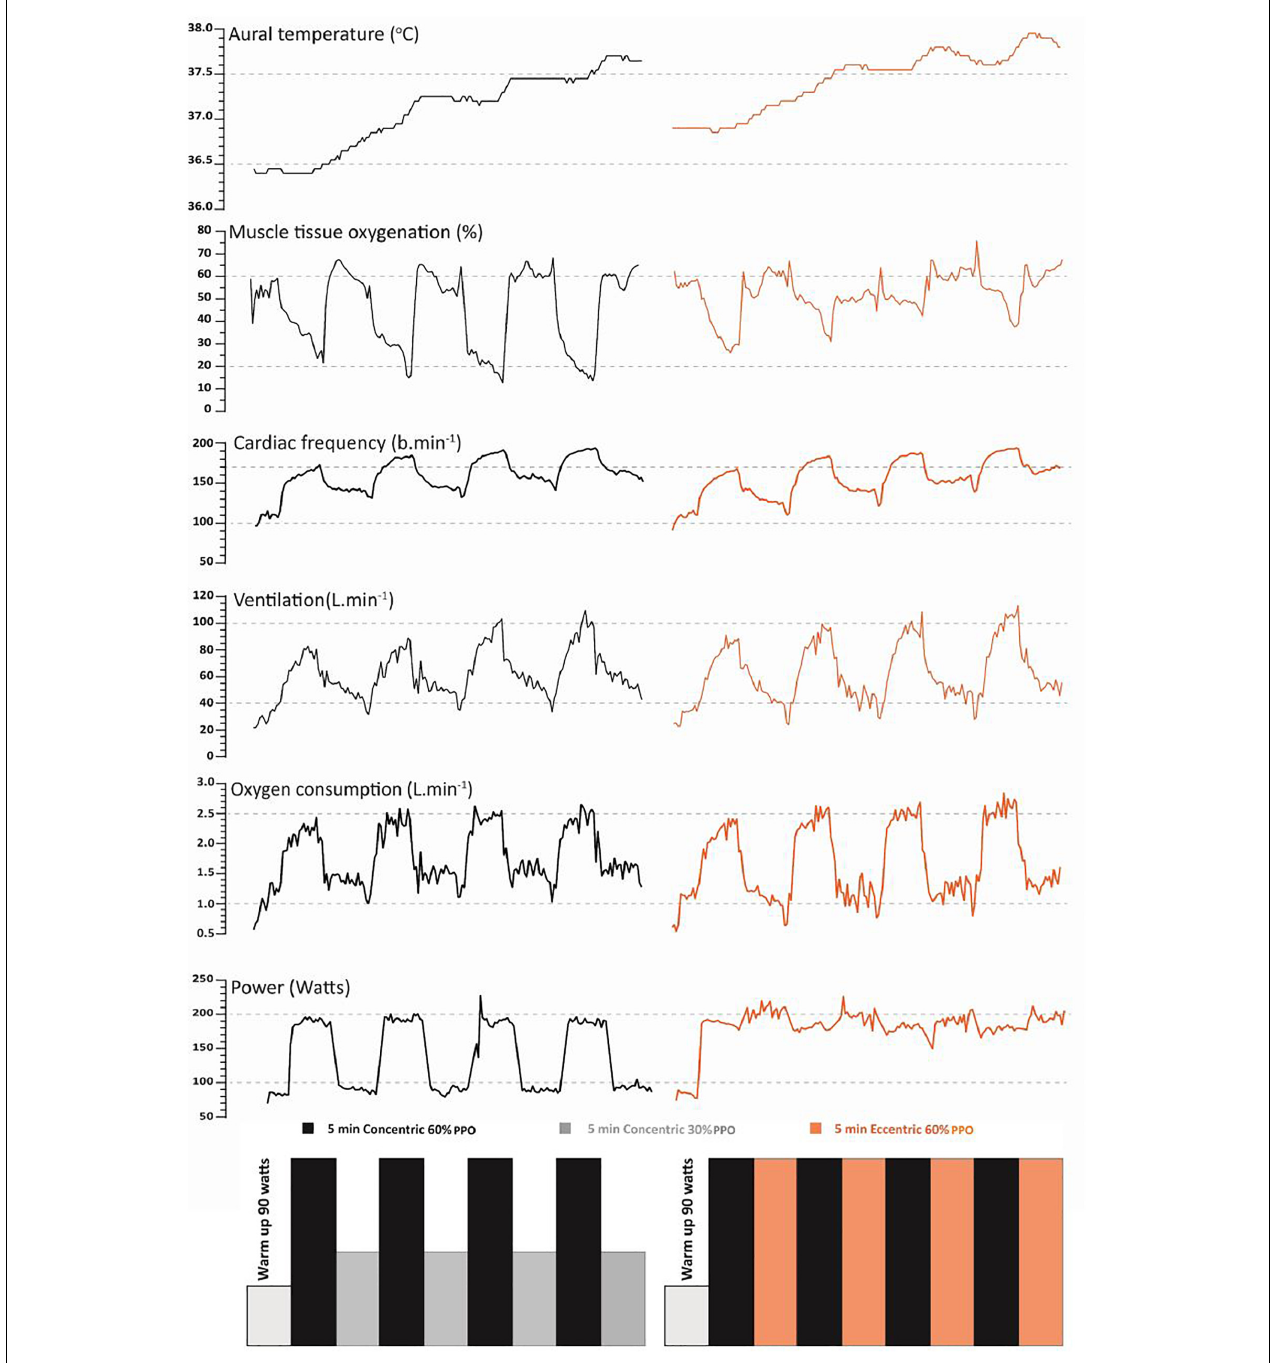
FIGURE 1 | Representative traces of the typical aural temperature ( ◦ C), muscle tissue oxygenation (%), heart rate (beats · min − 1 ), minute ventilation (L · min − 1 ), oxygen consumption (L · min − 1 ) and power output (W) from an individual participant in response to the high intensity (60% PPO) interval (4 × 5 min) recumbent cycling trials that differed according to the 5 min recovery periods [concentric cycling at 30% PPO ( CON R ) and eccentric cycling at 60% PPO ( ECC R )].